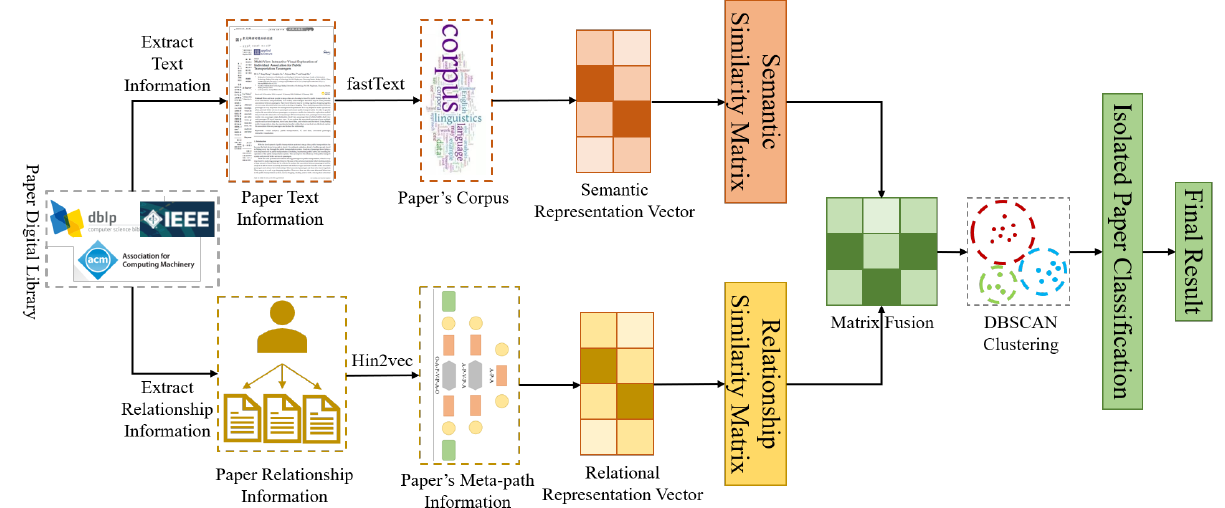
Figure 2. Dual-Channel Heterogeneous Graph Network